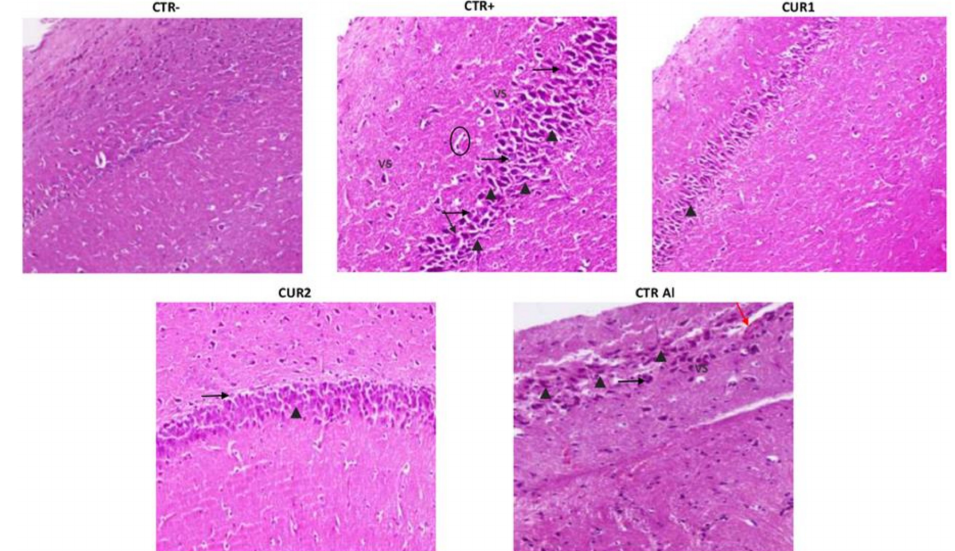
Figure 6. Effect of co and post-treatment of curcumin on histological examination of the hippocampus on rat model of AD induced by chronic administration of AlCl3. The red arrow indicates apoptosis. The black arrowhead indicates necrosis and pyk-notic nuclei. The black arrow indicates lymphocyte infiltration. VS indicates severe congestion in the karyopyknosis of neurons. Note: CTR − : negative control group; CTR+: positive control group (treated by aluminum chloride (AlCl3)); CUR1: co-treatment with curcumin; CUR2: post-treatment with curcumin; CTRAl: exposed to AlCl3 for 90 days and survive 60 days without any